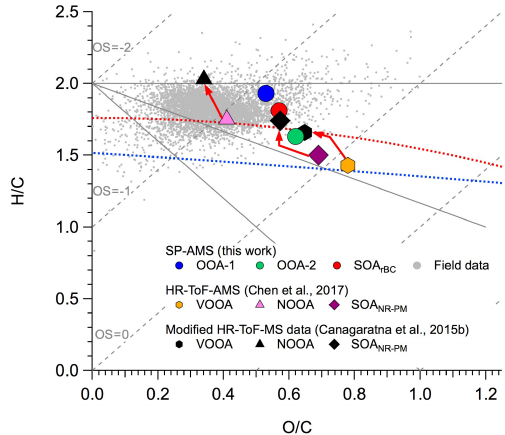
Figure 7. Van Krevelen diagram: red arrows indicate the changes in the elemental ratios of VOOA, NOOA factors, and SOA NR-PM measured with the HR-ToF-AMS after applying the correction fac- tors for more oxygenated organic species proposed by Canagaratna et al.